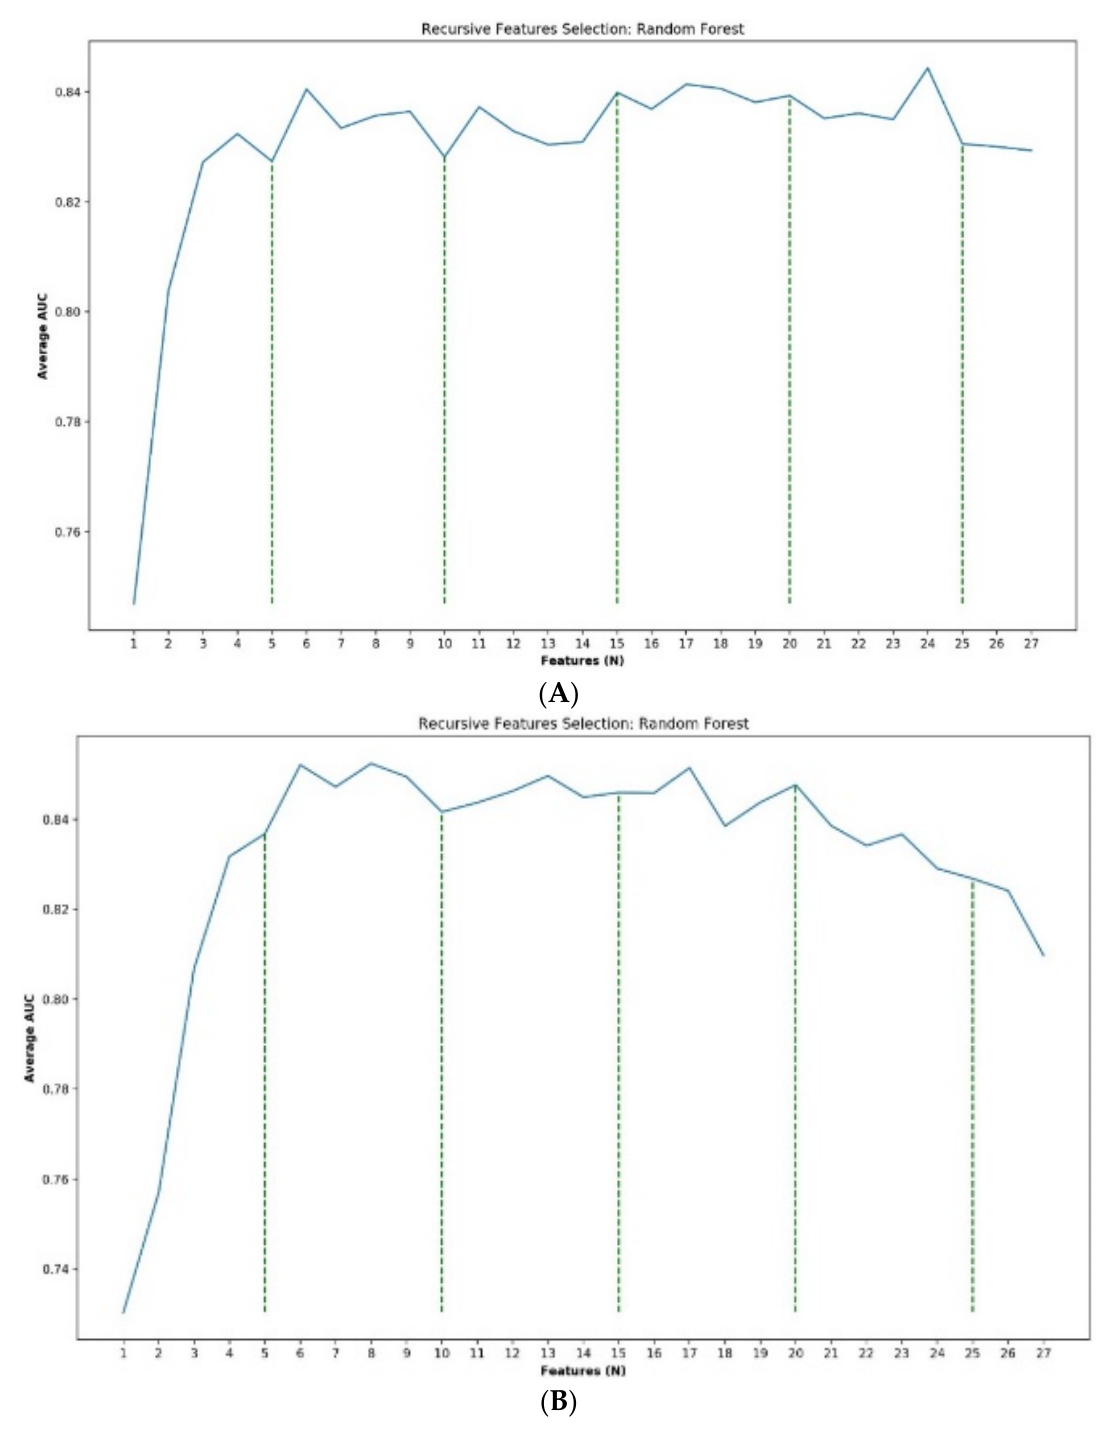
Figure 2. ( A , B ) Averaged areas under the receiver operating characteristic curves (AUC) of the recursive feature selection results. The models were trained and evaluated using 100 random splits of 90/10.